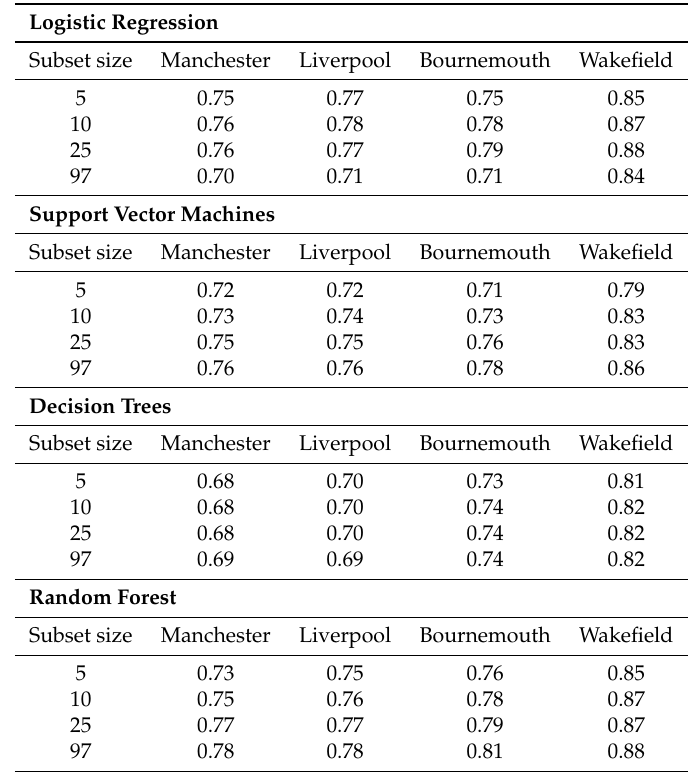
Table 5. Average AUC values for dimensionality reduction by principal component analysis (PCA). Logistic Regression Subset